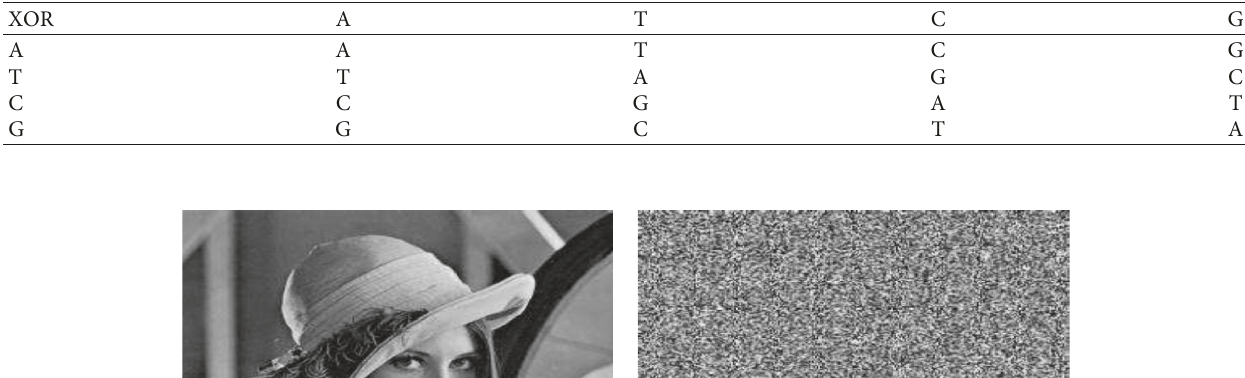
Figure 13: Encrypted flowchart. Table 2: XOR operation for DNA